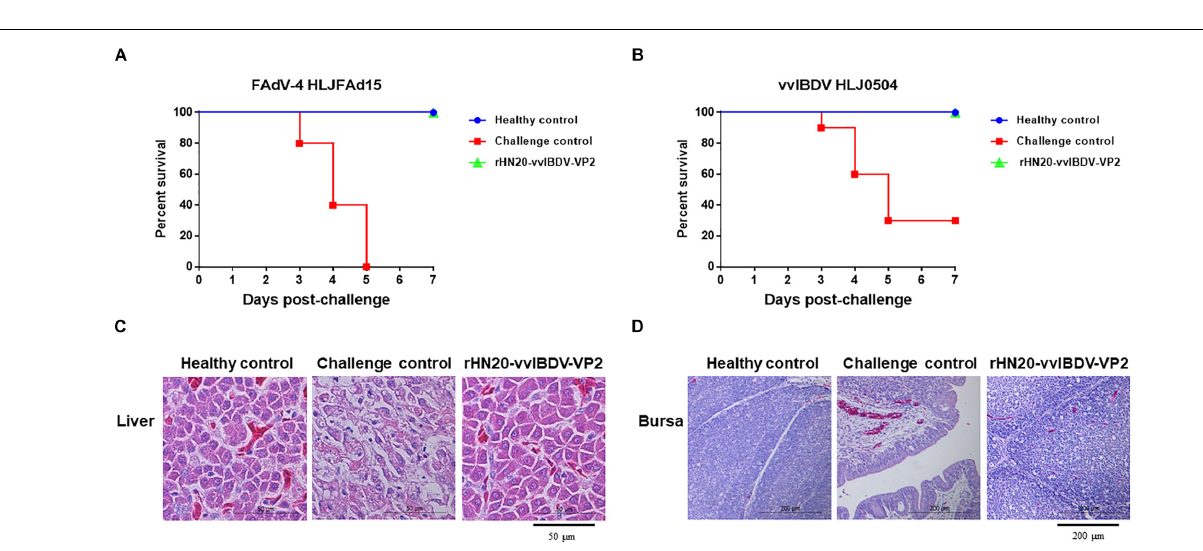
FIGURE 8 | Efficacy of live rHN20-vvIBDV-VP2 vaccine against FAdV-4 and vvIBDV. Immunized chickens were challenged with FAdV-4 or IBDV. Survival rates of chickens after (A) FAdV-4 or (B) IBDV challenge. (C) Pathological sections of liver from FAdV-4 challenged chickens. Scale bar, 50 µ m. (D) Pathological sections of bursas from IBDV challenged chickens. Scale bar, 200 µ